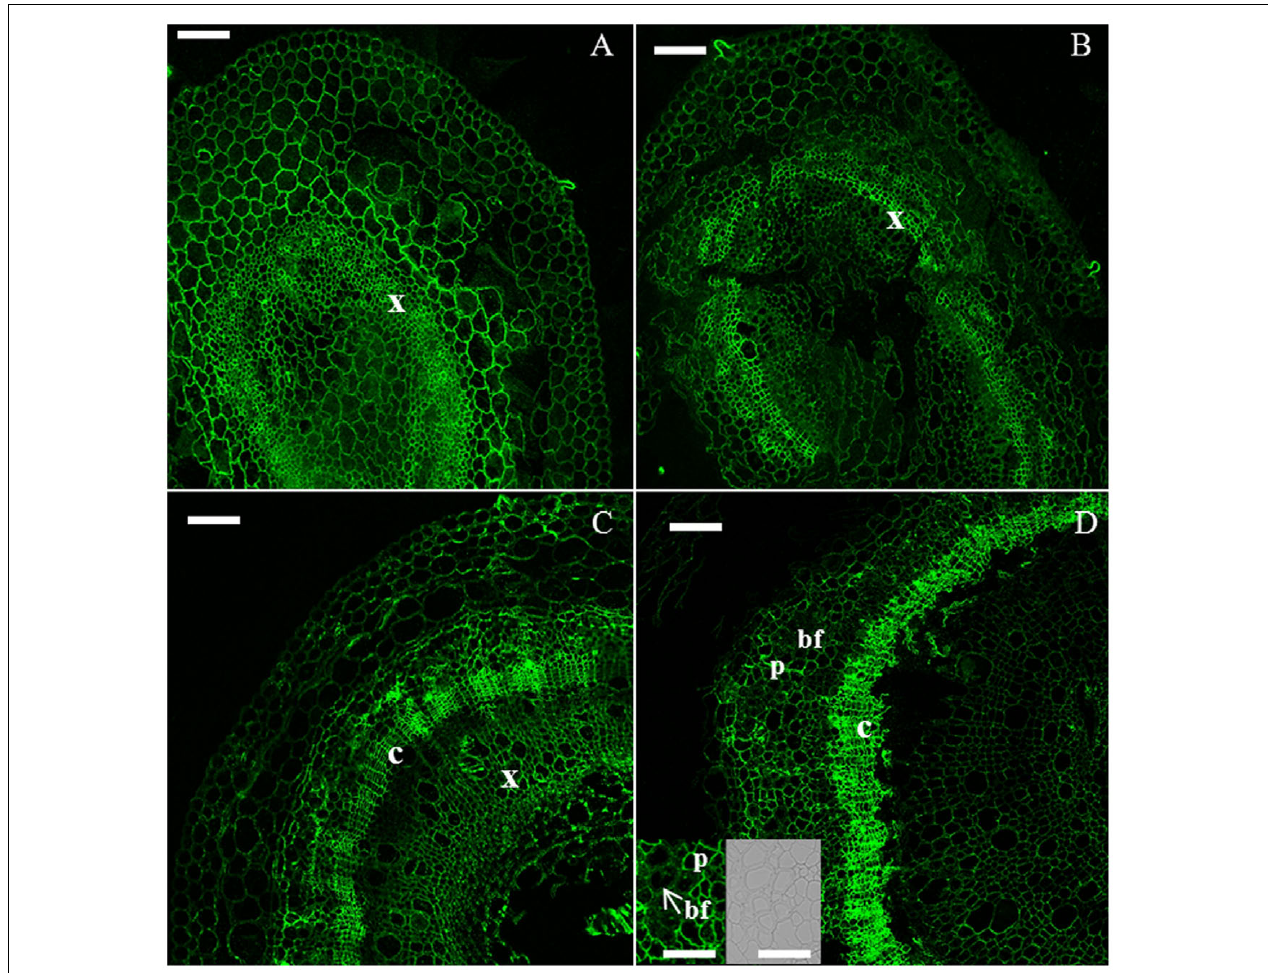
FIGURE 2 | Immunodetection of the LM5 epitope specific for β -1,4- D -galactan. H6 ( A , top left), H9 ( B , top right), H15 ( C , bottom left), H20 ( D , bottom right). bf, bast fiber; c, cambium; p, parenchyma; x, xylem. Scale bar: 100 µ m in the main pictures and 50 µ m in the insets. The inset shows a zoomed detail of the cortex, where bast fibers are visible. For clarity of presentation, the corresponding DIC image is provided in (D) .